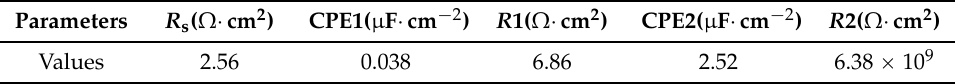
Table 1. Electrochemical parameters obtained from EIS spectra of the post-laser-treated TZM alloy immersed in 3.5% NaCl solution for seven